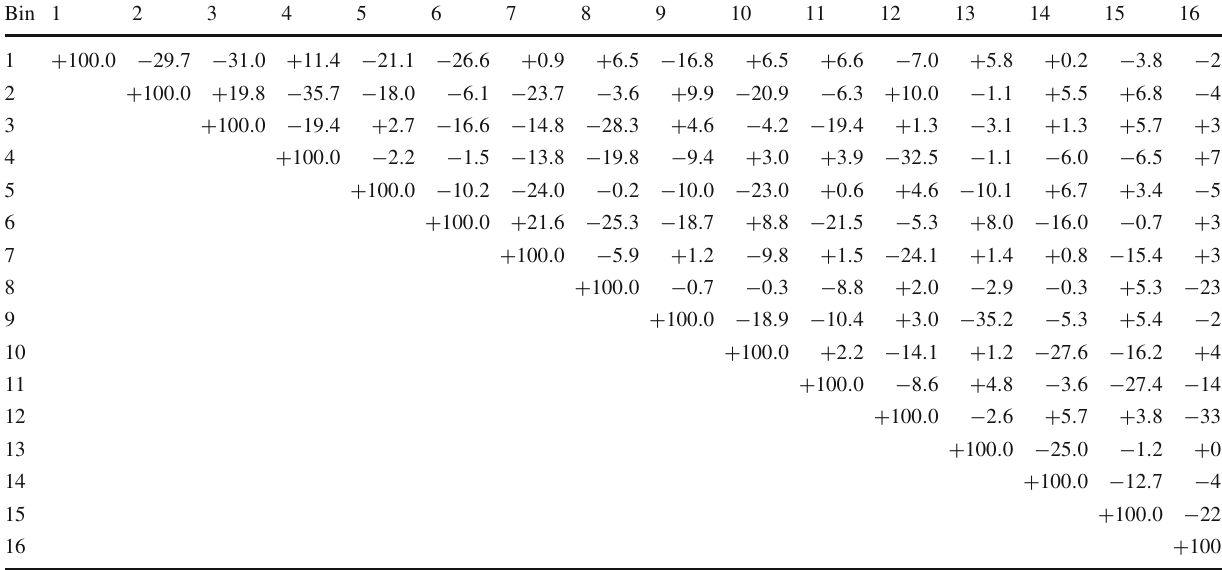
Table 9 The correlation matrix of statistical uncertainties for the normalized tt double-differential cross sections as a function of M ( tt ) and y ( t ) . The values are expressed as percentages. For bin indices see Table 8 Bin 1